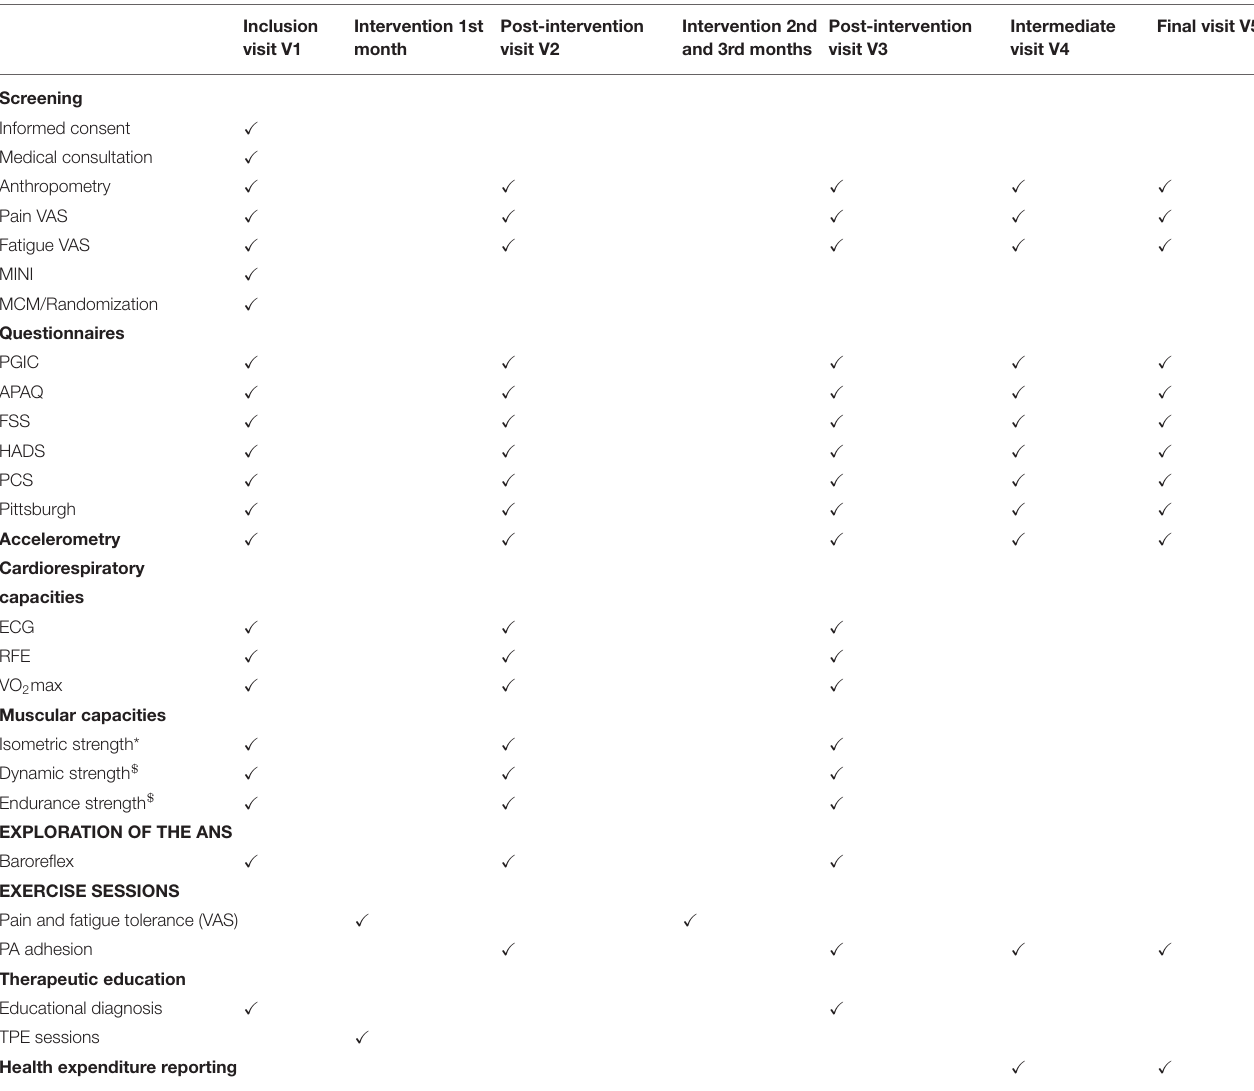
TABLE 2 | Assessment measures timetable.